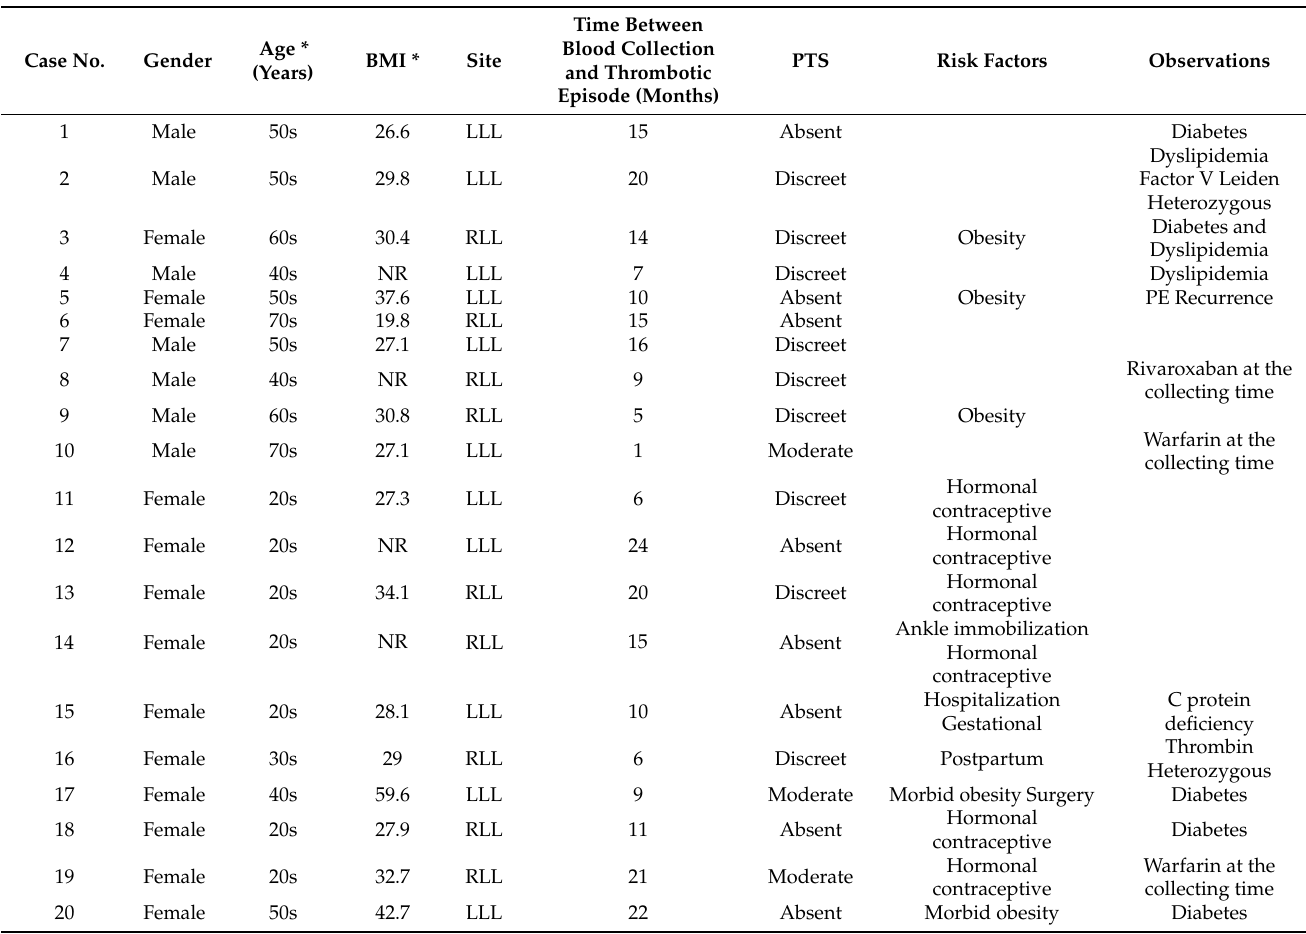
Table A1. Clinical summary of patients with DVT. LLL: Lower-left limb, RLL: Lower-right limb; BMI: above (25–29.99), obesity I (30–34.99), obesity II (35–39.99), morbid obesity (>40). PTS: post-thrombotic syndrome. PE: pulmonary throm- boembolism. * Age and body mass index (BMI) at thrombosis